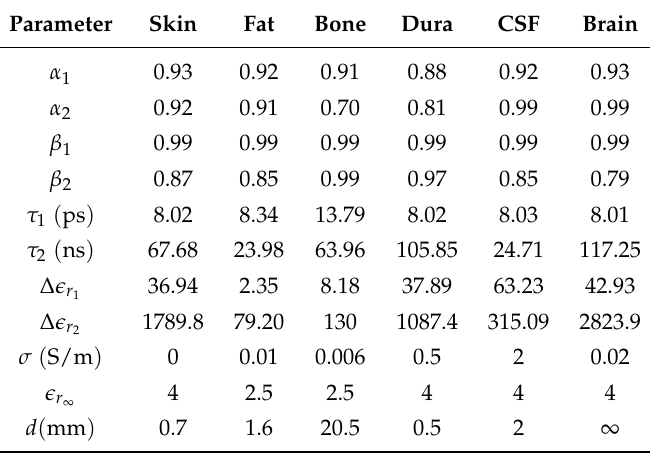
Table 1. Dielectric and geometrical parameters of the simulated layered